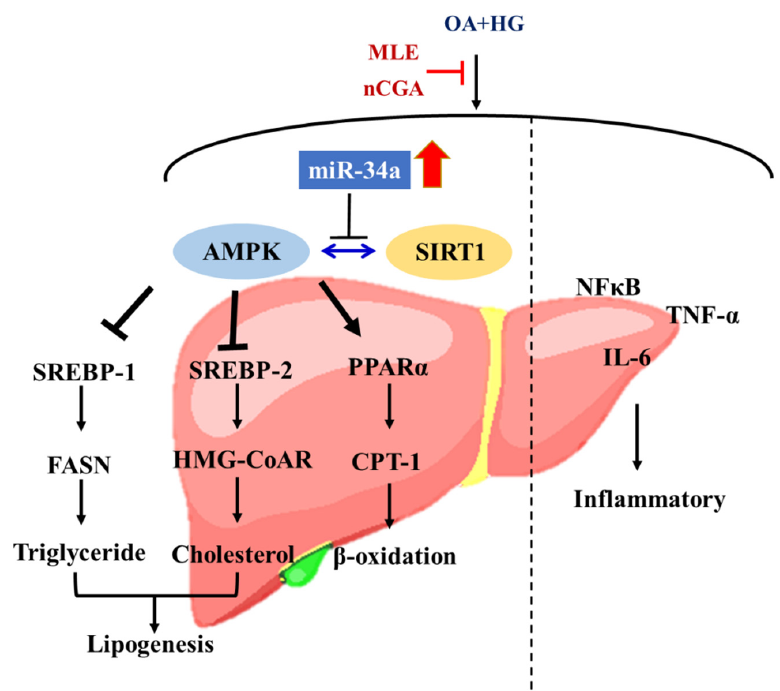
Figure 7. The MLE and nCGA decreased inflammation by inhibiting NF- κ B signaling, and regulating the SIRT1-AMPK pathway via miR-34a reduced lipogenesis.